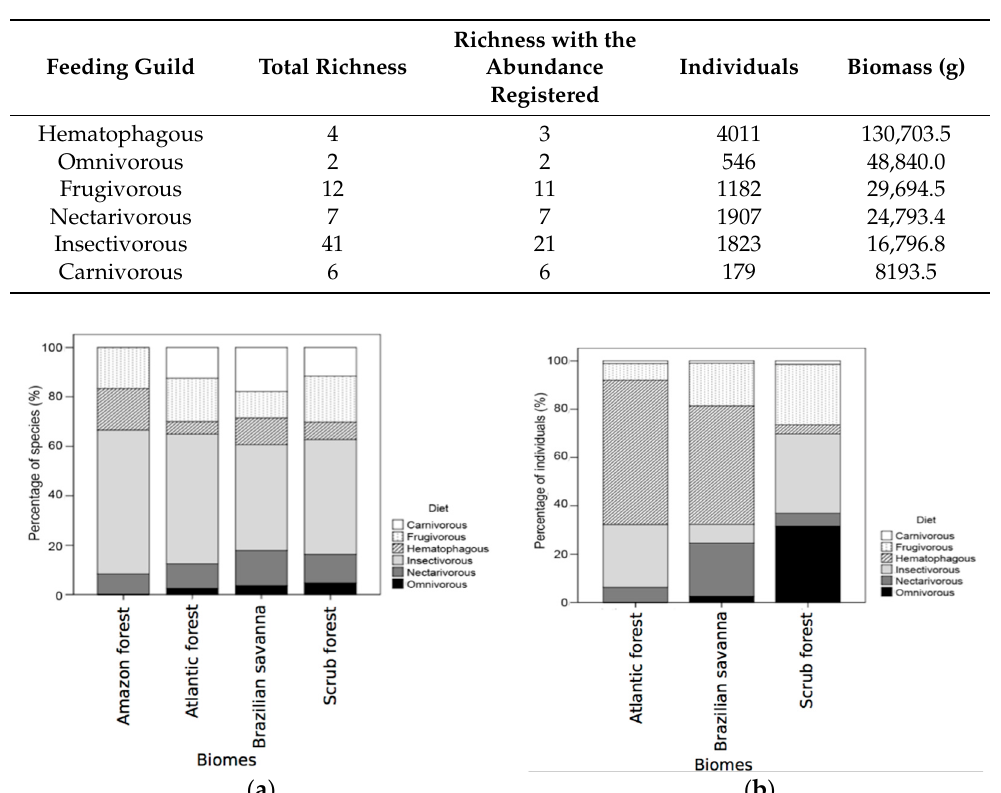
Figure 6. Percentage of the number of species ( a ) and individuals ( b ) of cave-dwelling bats from different feeding guilds between Brazilian biomes.